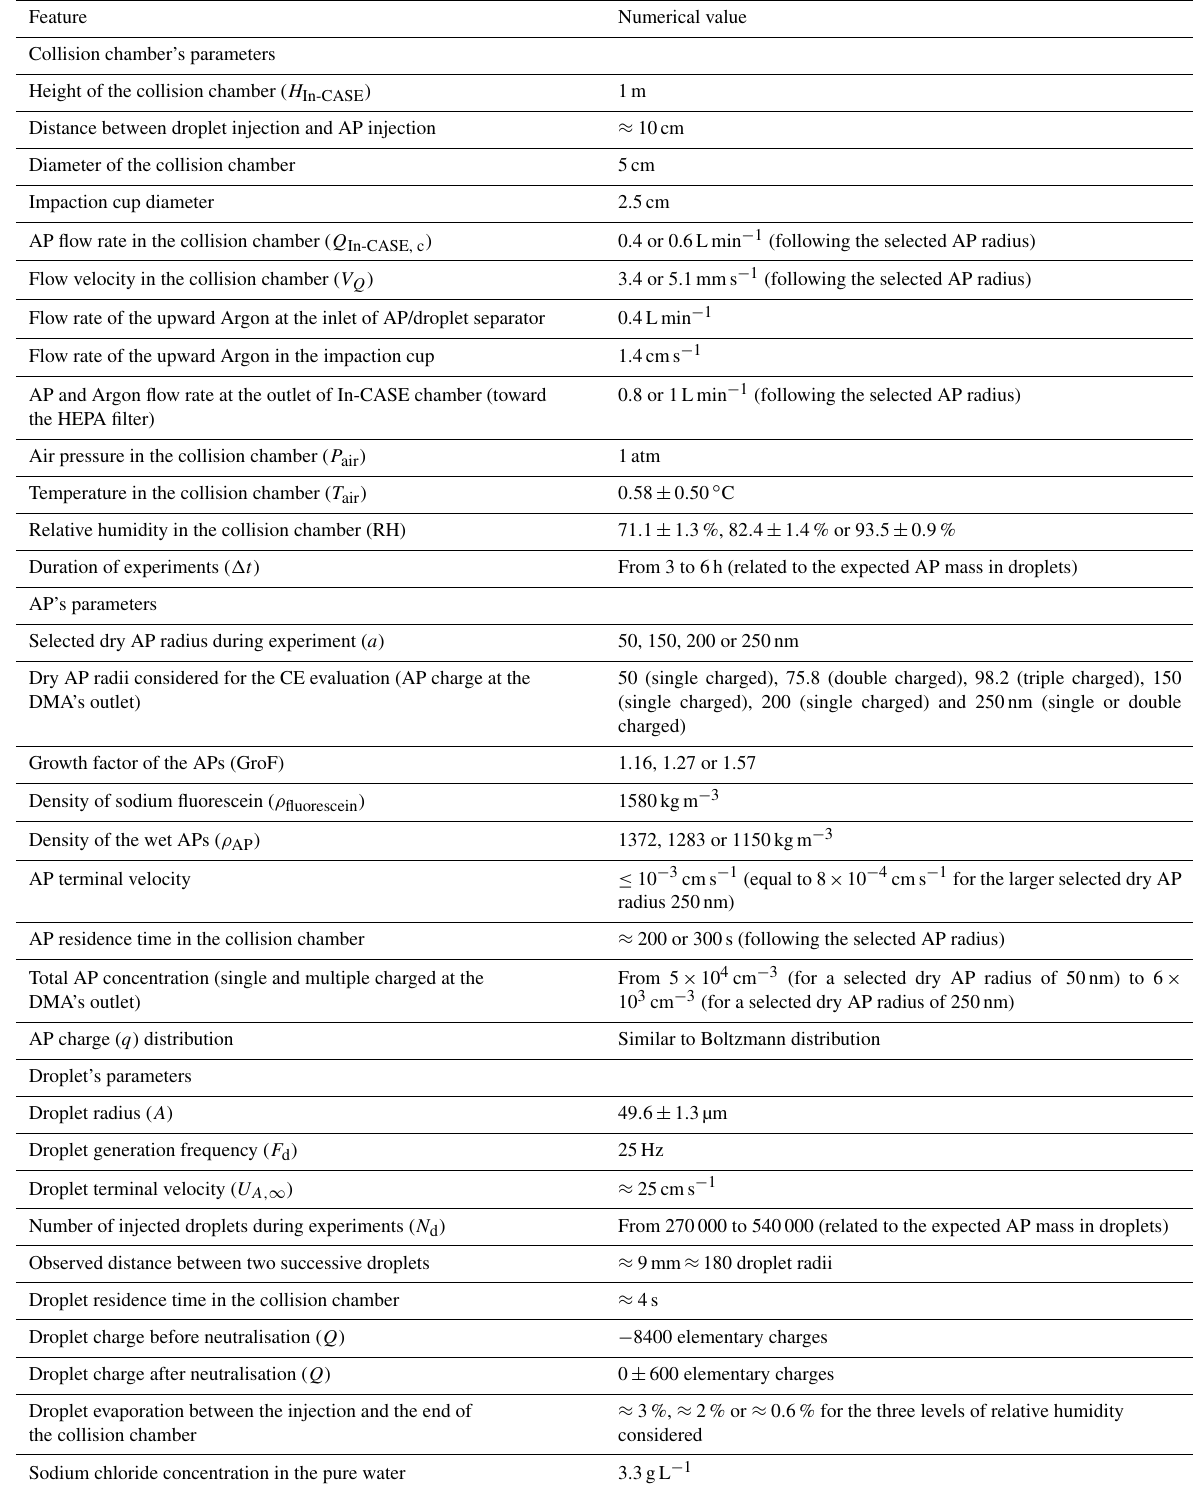
Table 2. Key features of the In-CASE